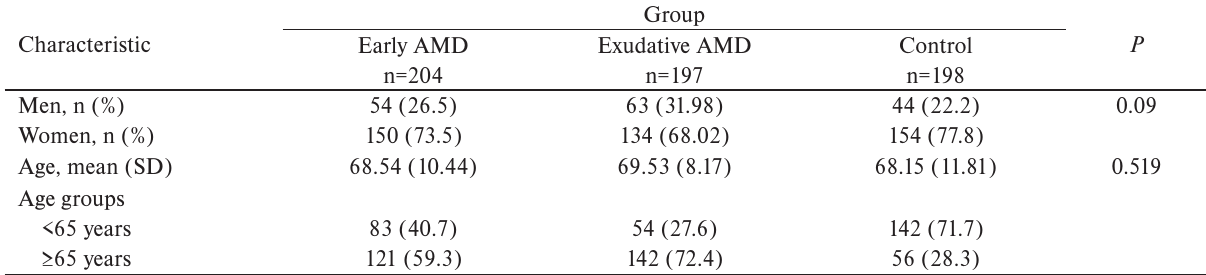
Table 1. Demographic characteristics of the study